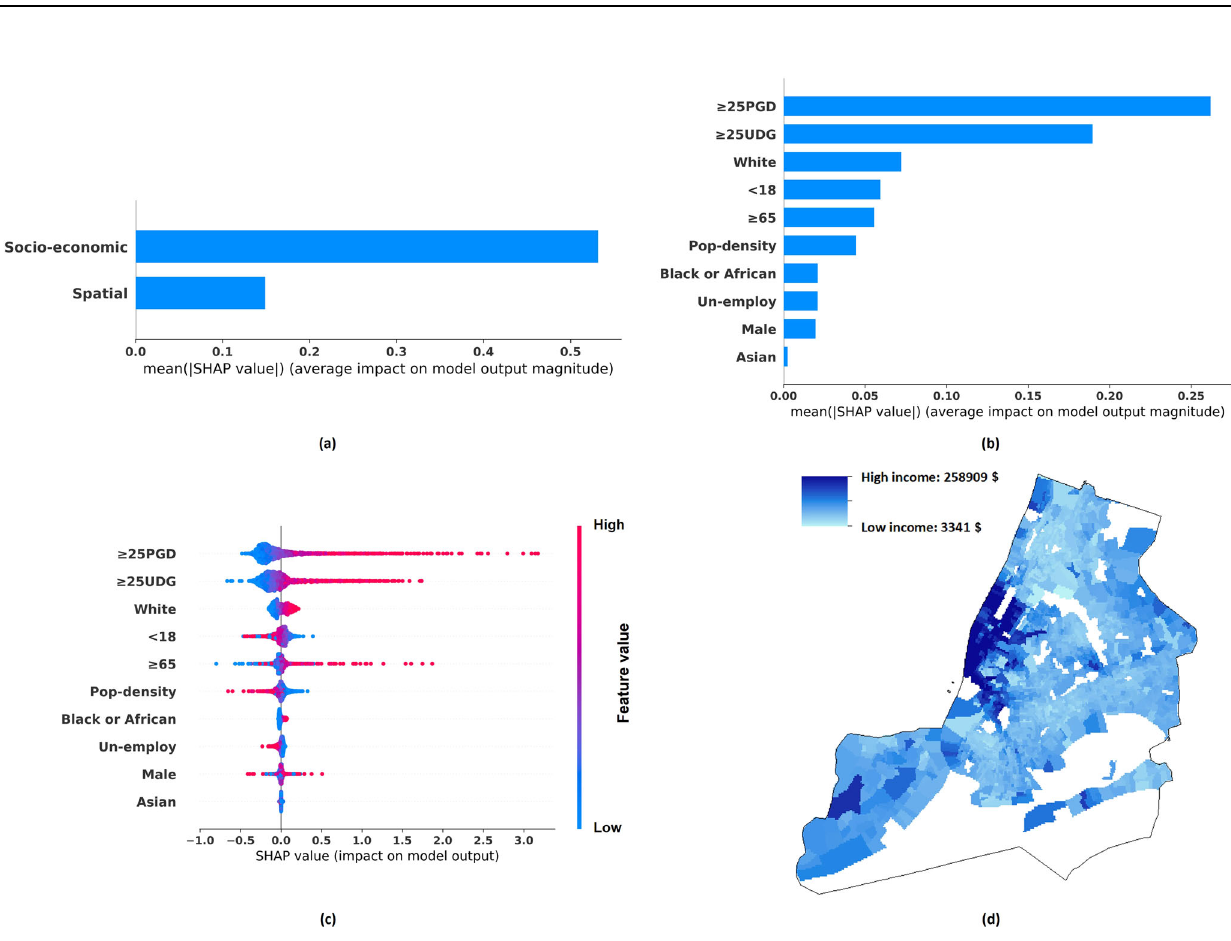
Fig. 2 Tract-level per-capita income distribution and SHAP analysis results. a The mean absolute SHAP value indicating the total contribution of spatial or socio-economic features to Tract-level per-capita income estimation. b The mean absolute SHAP value indicating the contribution of individual socio- economic features to Tract-level per-capita income estimation. c The SHAP value indicating the contribution of individual socio-economic features to Tract-level per-capita income estimation, with each dot corresponding to a value of a particular Tract/district. d Tract-level per-capita income